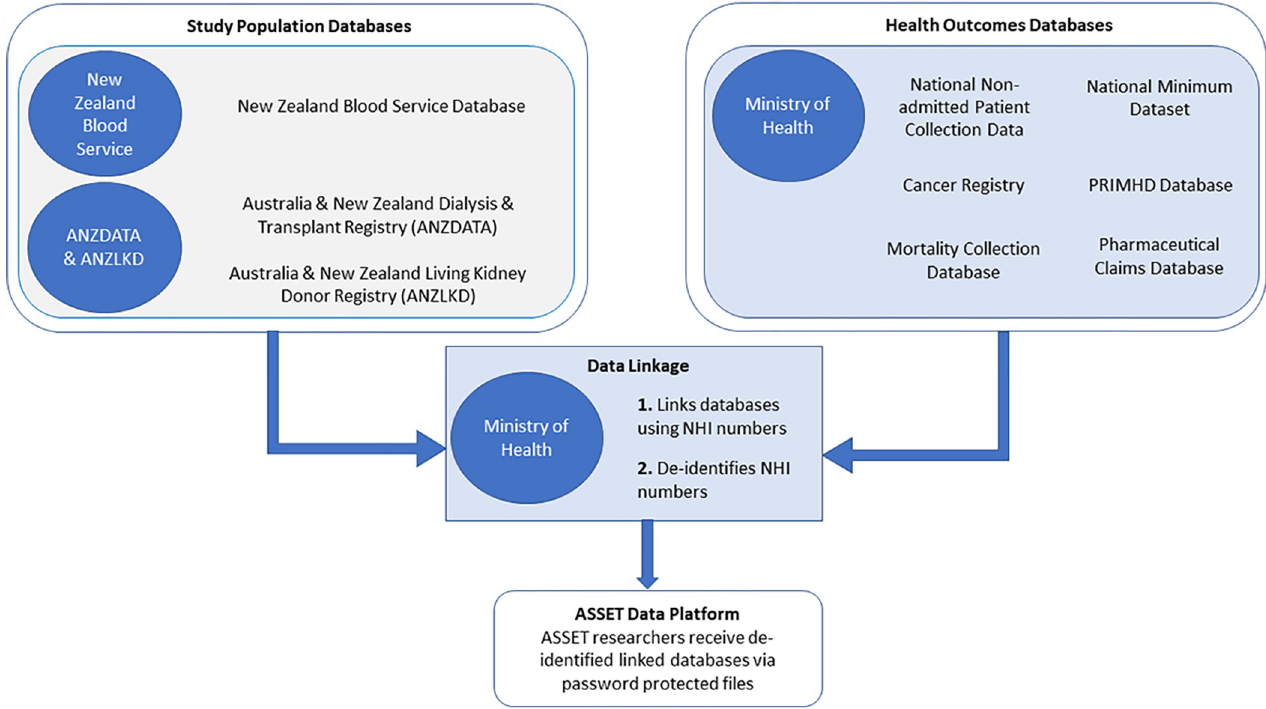
Fig 3. Process of data linkage by the New Zealand Ministry of Health. Linking study population and health services and outcomes databases to create the ASSET linked data platform.